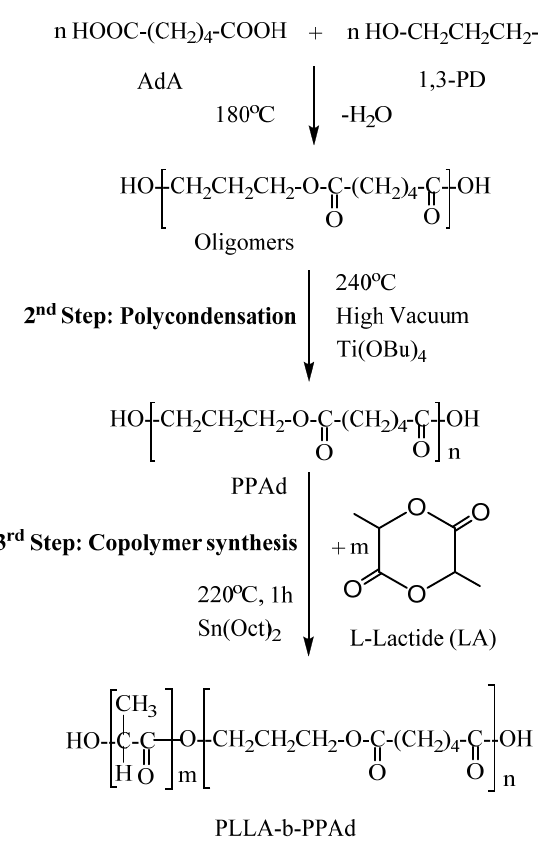
Figure 1. Synthesis of poly( L -lactide)- b -poly(propylene adipate) copolymers.